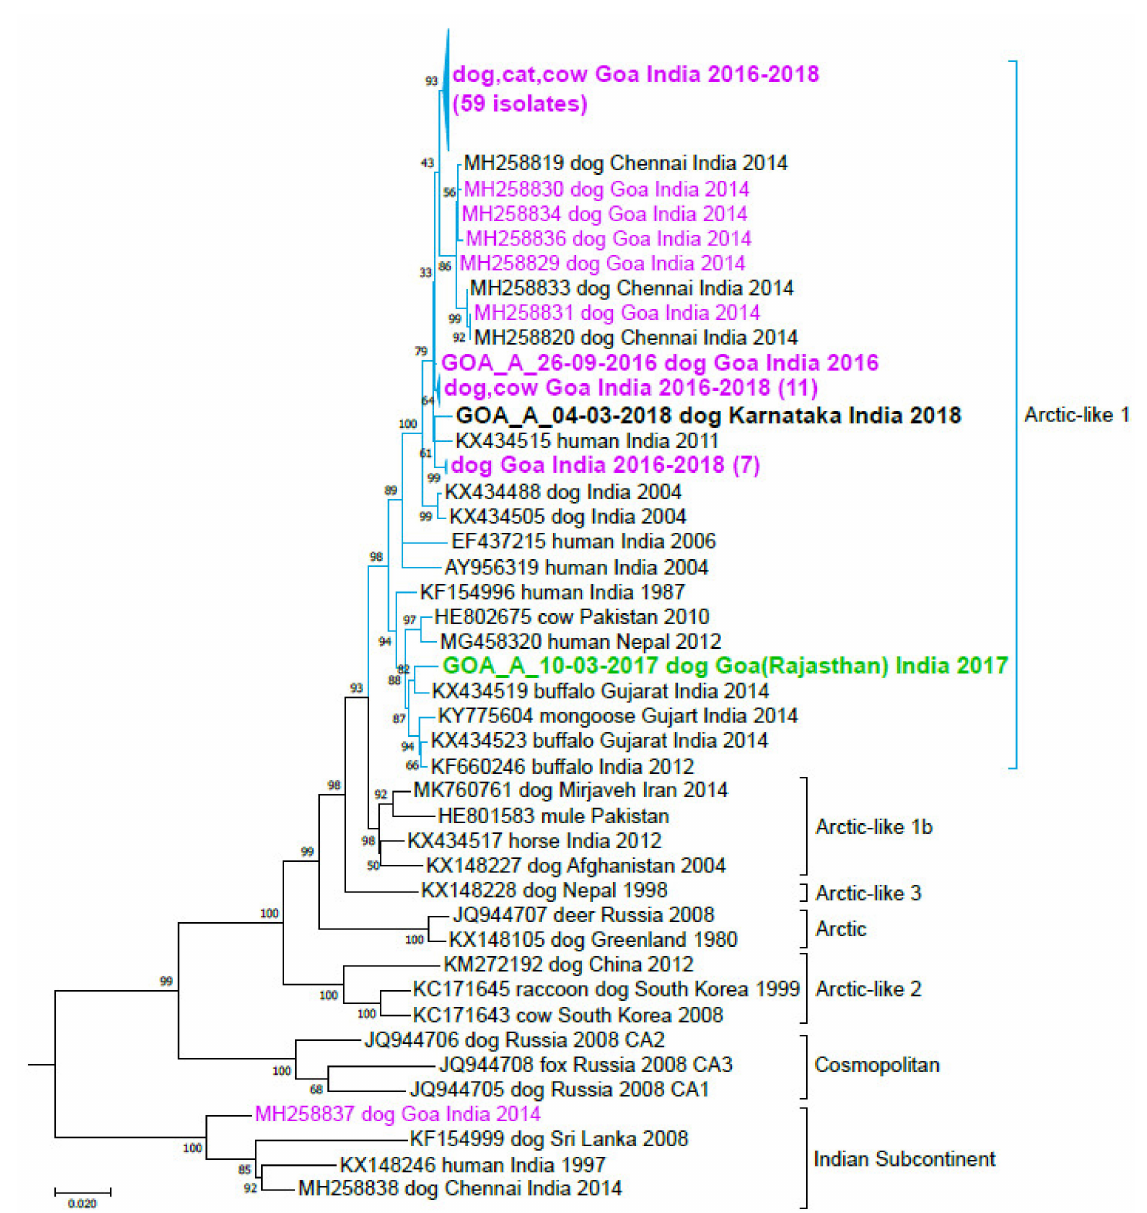
Figure 2. Phylogenetic analysis of MinION sequences generated in Goa, India. Complete nucleoprotein gene sequences from Goa rabies virus isolates were compared to publicly available sequences. Reference sequences were chosen based on sequence similarity to the newly generated sequences or inclusion in rabies Arctic-like 1, Arctic, Arctic-like 2, Arctic-like 3, Indian Subcontinent, and Cosmopolitan phylogenetic clades (from [31]). Newly generated sequences are shown in bold; several sequences are collapsed for viewing ease. Sequences from Goa isolates are shown in magenta. Translocation case from Rajasthan is highlighted in green. Accession number, host, location, and collection date are included for reference, when available; additional sample details can be found in Table S1. Phylogenetic analysis was performed by maximum likelihood based on a GTR + G + I model. Di ff erences between samples are shown by the number of changes per site along the horizontal axis. Bootstrap values near the branch points represent the percentage of trees that had the same clustering out of 1000